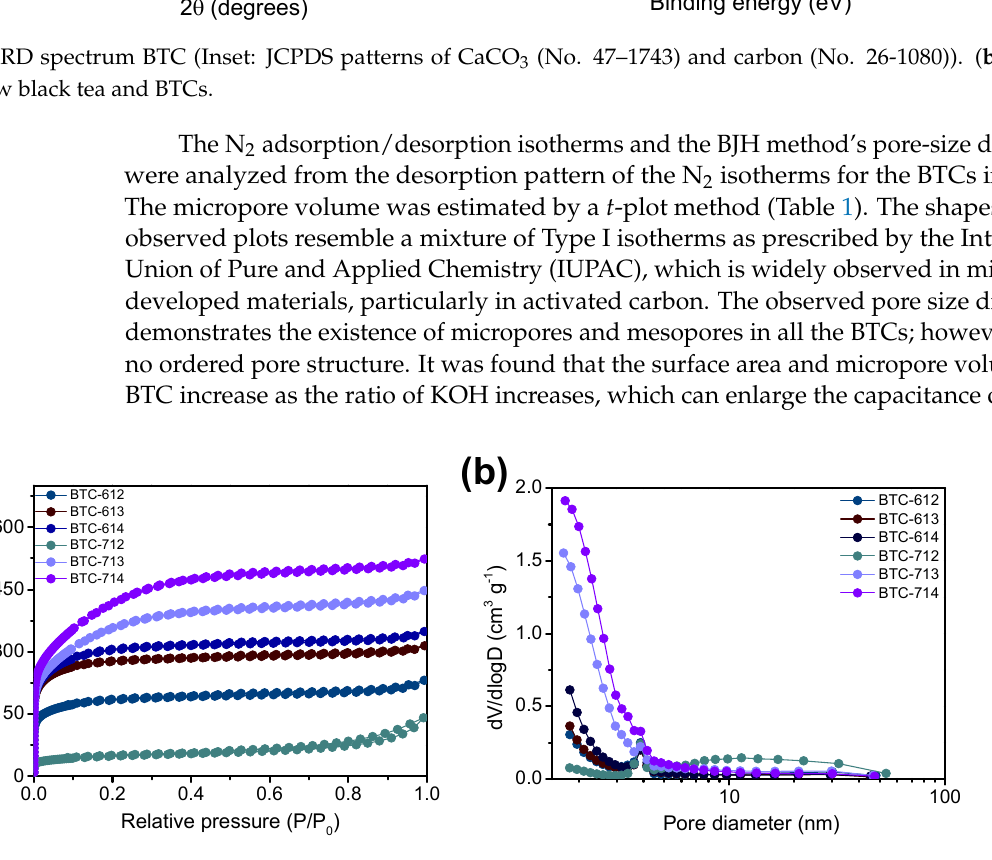
Figure 4. ( a ) N 2 adsorption/desorption isotherms and ( b ) pore size distribution of the